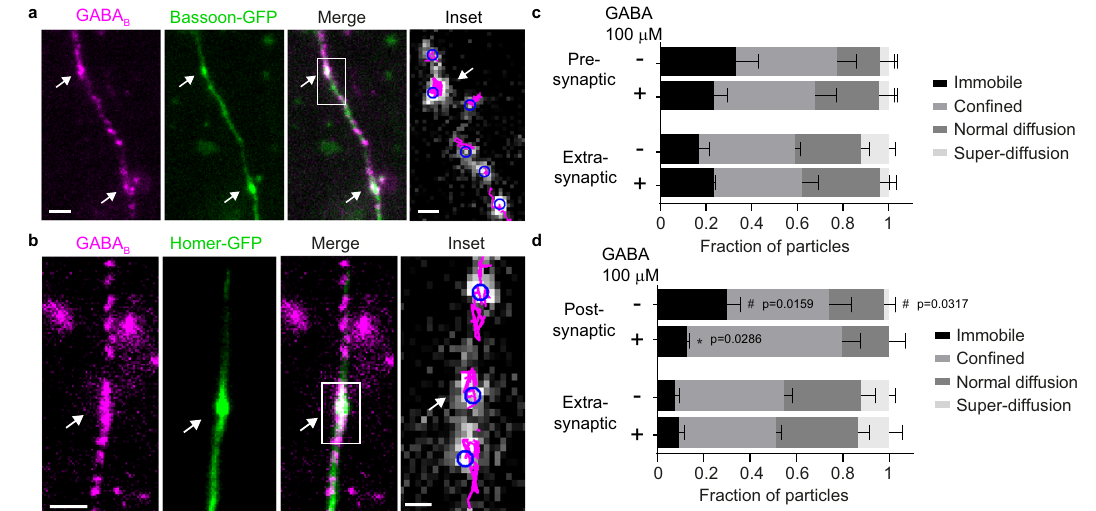
Fig. 5 | GABA B receptors are dynamically trapped at synaptic sites in hippo- campal neurons. a , b Representative TIRF images of SNAP-GABA B1 (magenta) co- transfected with Bassoon-GFP ( a ) or Homer-GFP ( b ) in hippocampal neurons and labeled with SNAP-549 (green). Images are representative of three independent experiments. Arrows indicate colocalization between GABA B1 and either Bassoon ( a ) or Homer ( b ) at synaptic sites. Insets, results of single-particle tracking applied to the regions delimited by the white boxes. Trajectories are shown as in Fig. 4b. c , d Frequency distributions of GABA B trajectories in hippocampal neurons clas- si fi ed in the four groups identi fi ed by the TAMSD analysis in basal and stimulated